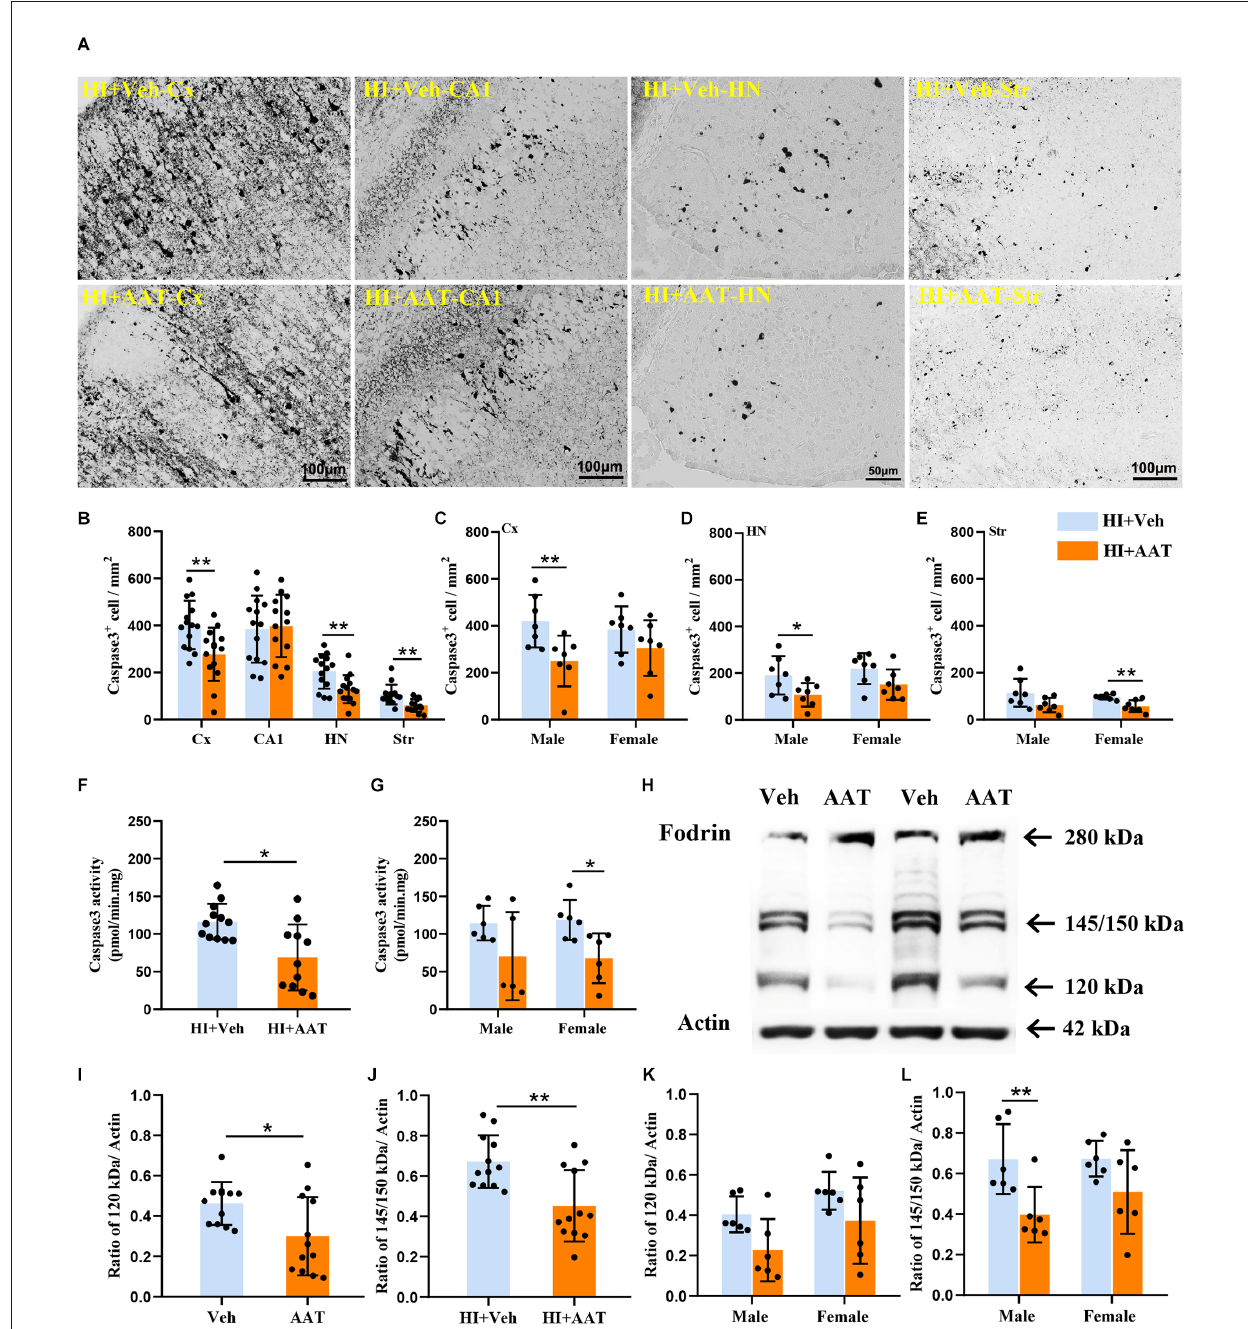
FIGURE6 Activation of caspase-3 and calpain in neonatal HI mice after AAT treatment. (A) The photomicrographs show immunochemistry staining of activated caspase-3 in the cortex (Cx), hippocampus (CA1), habenula nucleus (HN), and striatum (Str) at 24 h after HI in the vehicle-treated and AAT-treated groups. (B) Quantification of cleaved caspase-3-labeled cells at 24 h after HI in the Cx, CA1, HN, and Str ( n = 14/group, p = 0.005 in Cx, p = 0.437 in CA1, p = 0.006 in HN, p = 0.001 in Str). (C) Quantification of cleaved caspase-3-labeled cells in the cortex at 24 h after HI in male and female mice ( n = 7/group, p = 0.008 for males and p = 0.193 for females). (D) Quantification of cleaved caspase-3-labeled cells in the habenula nucleus at 24 h after HI in male and female mice ( n = 7/group, p = 0.028 for males and p = 0.067 for females). (E) Quantification of cleaved caspase-3-labeled cells in the striatum at 24 h after HI in male and female mice ( n = 7/group, p = 0.059 for males and p = 0.006 for females). (F) The caspase-3 activity in cortical tissue homogenate was measured at 24 h after HI in the AAT-treated and vehicle-treated groups (Veh = 12, AAT = 11, p = 0.011). (G) Measurement of caspase-3 activity at 24 h after HI in male and female mice (Veh = 6, AAT = 5, p = 0.273 in male; n = 6/group, p = 0.015 in female). (H) Representative immunoblotting of fodrin and actin in the cortical tissue from the injured hemisphere of the vehicle and AAT treatment groups at 24 h after HI. (I) Quantification of 120 kDa fragment expression at 24 h after HI in vehicle-treated and AAT-treated groups ( n = 12/group, p = 0.024). (J) Quantification of 145/150 kDa fragment expression at 24 h after HI in vehicle-treated and AAT-treated groups ( n = 12/group, p = 0.002). (K) Quantification of 120 kDa fragment expression at 24 h after HI in male and female mice ( n = 6/group, p = 0.051 for males and p = 0.097 for females). (L) Quantification of 145/150 kDa fragment expression at 24 h after HI in male and female mice ( n = 6/group, p = 0.007 for males and p = 0.086 for females). * p < 0.05, ** p <